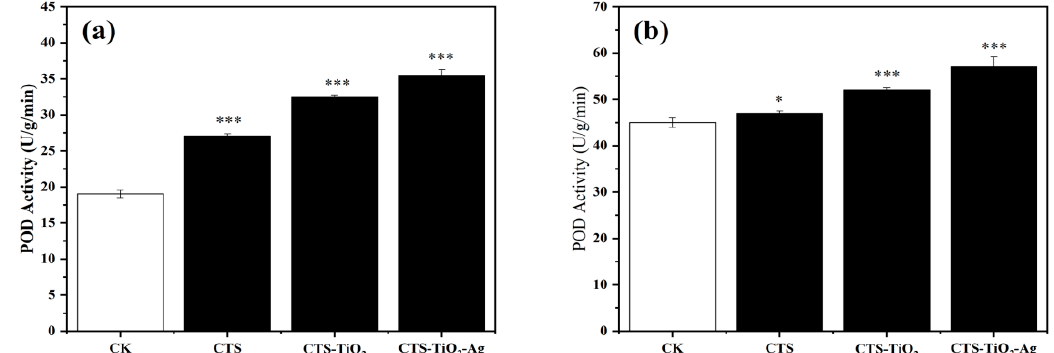
Figure 7. Effect of treatment with three different materials on peroxidase activity: ( a ) potato; ( b ) strawberry. CK: Potatoes and strawberries without any treatment; CTS: CTS applied to form film- treated potatoes and strawberries; CTS-TiO 2 : CTS-TiO 2 applied to form film-treated potatoes and strawberries; CTS-TiO 2 -Ag: CTS-TiO 2 -Ag applied to form film-treated potatoes and strawberries. Data given demonstrate the average of at least three replications (n = 10) ± SD. Asterisks within rows indicate significant differences (* p < 0.05, ** p < 0.01, *** p < 0.001), according to Student’s t -test.